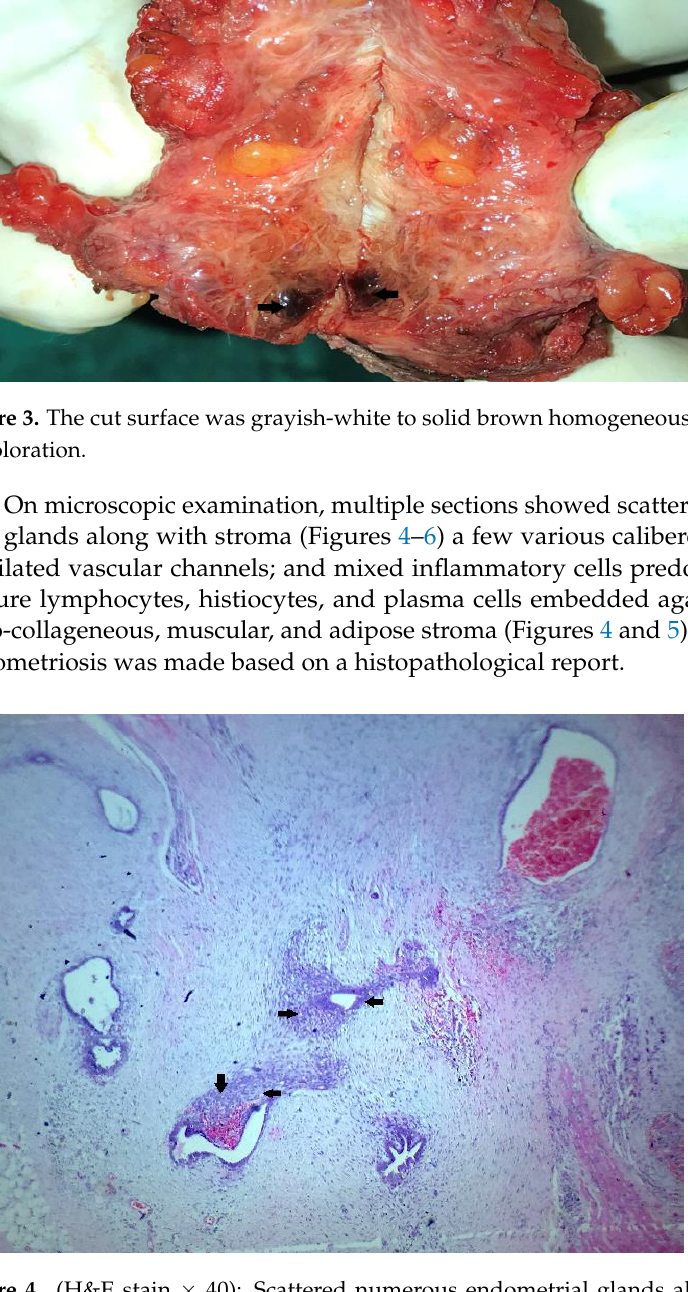
Figure 2. Wide local excision 6 × 4 × 1.4 cm; grayish-brown to black in color.